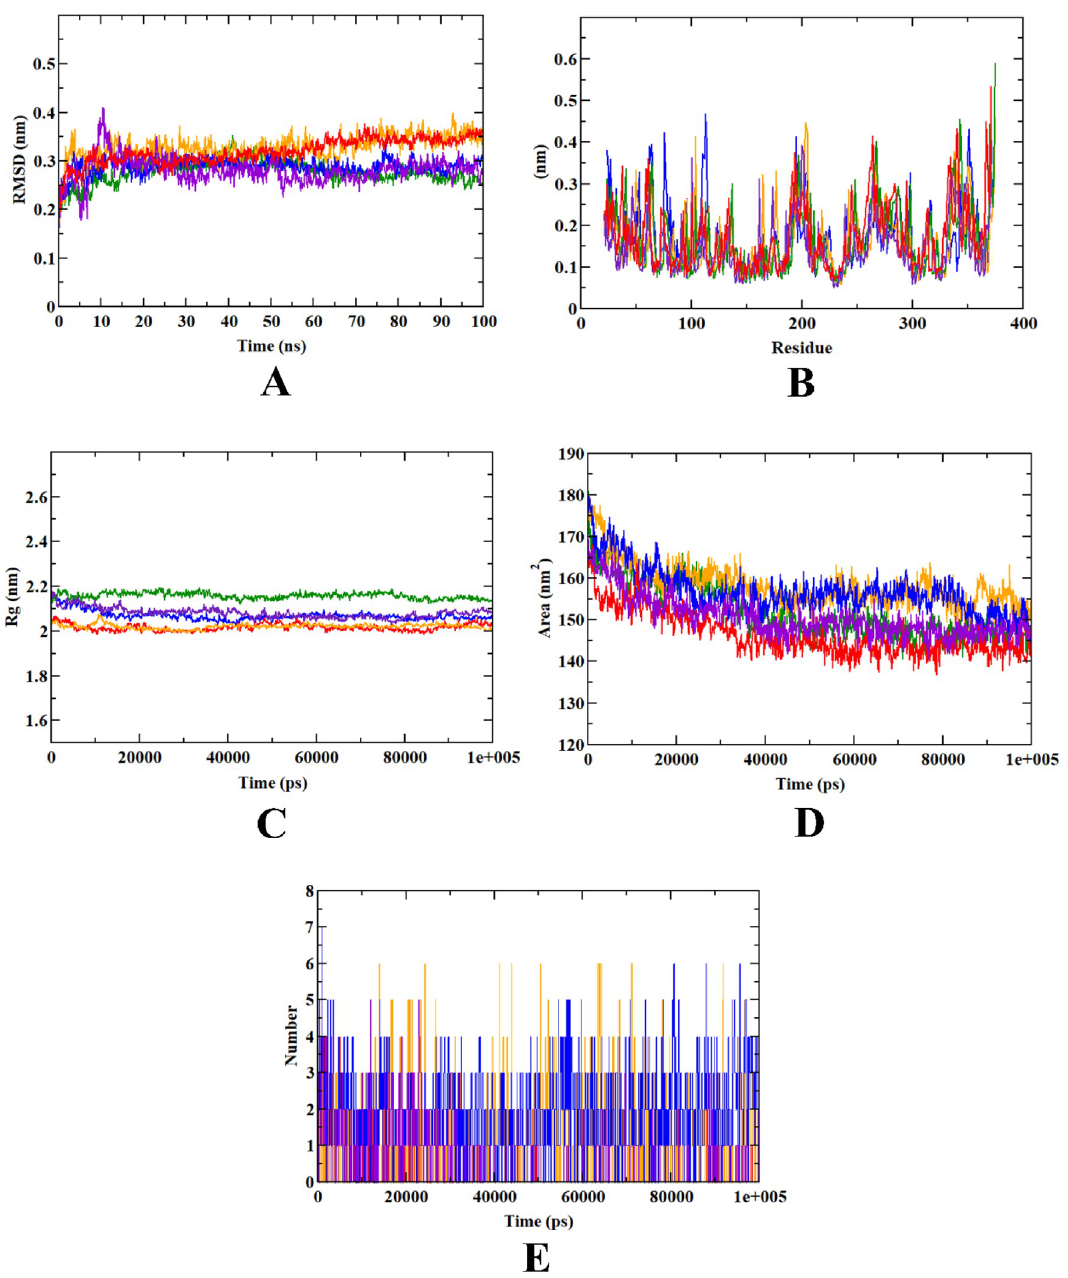
Fig 13. Visualization of MD trajectories of JME phytocompounds and metformin complexed with human MAPK3 protein run for 100 ns. A) protein-ligand complex RMSD, B) protein-ligand complex RMSF, C) protein-ligand complex Rg, D) protein-ligand complex SASA, E) ligand hydrogen bonds. (Green: apoprotein, orange: protein-caffeic acid complex, purple: protein-DBDEA complex, navy blue: protein-syringic acid complex, red: protein-metformin complex).